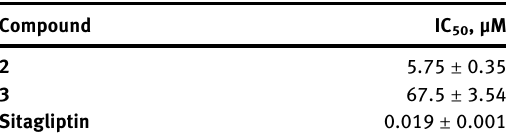
Table  : IC  values of compounds  –  for DPP –  inhibition.